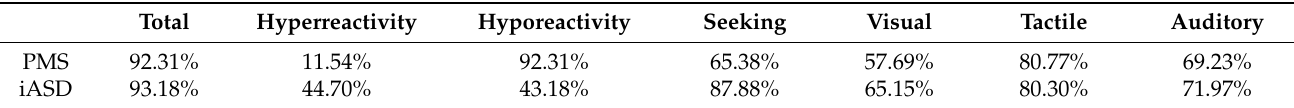
Table 3. Percentage of participants falling in the clinically significant range on the SAND.